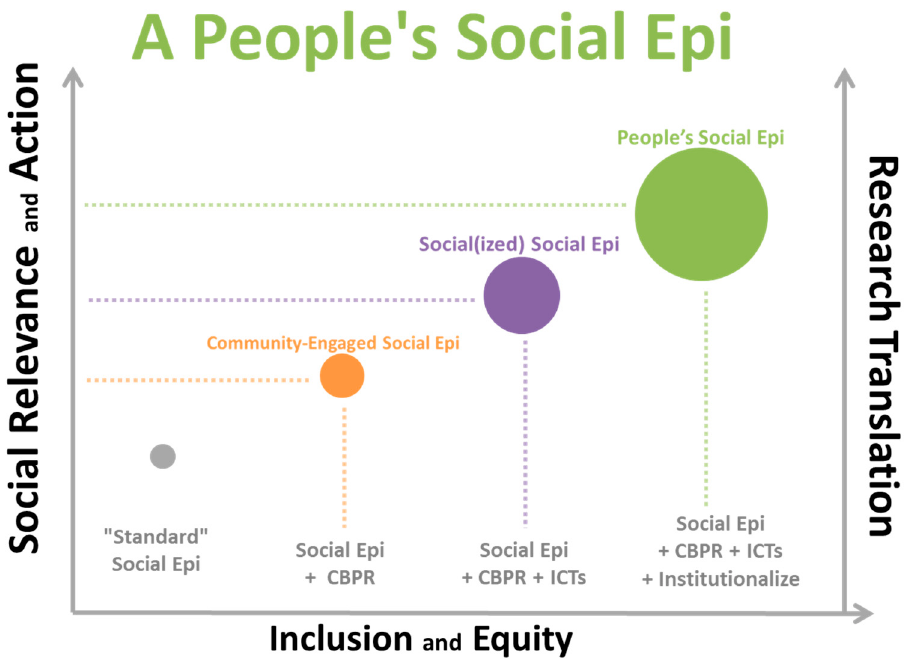
Figure 1. A People’s Social Epi Framework for Research Translation and Action. People’s Social Epi framework for conceptualizing how integrating social epidemiology with CBPR, ICTS, and local efforts to institutionalize this practice can improve prospects for social inclusion, equity, and action. The sizing of the circles is mainly intended to render greater visual distinction between tiers and to convey a general sense of incrementality. It is not to suggest a fixed or simple additive property of incorporating each framework component.